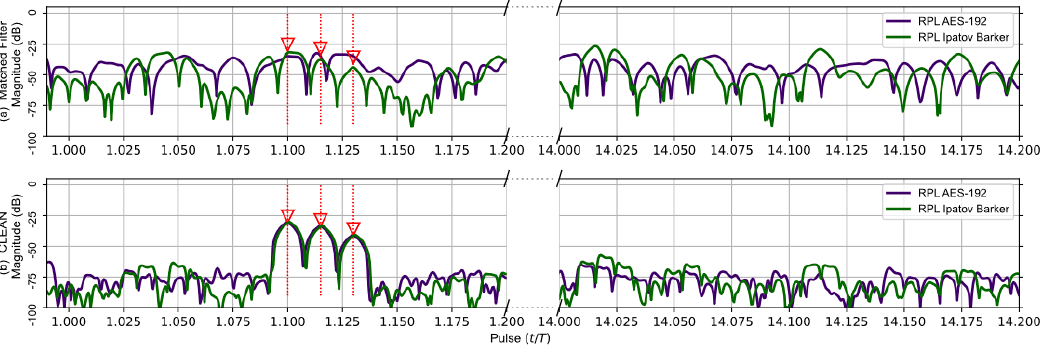
Figure 8. Duplicate data from Figure 7; focused on the tight group of three targets buried in the side lobes before CLEAN. The CLEAN algorithm was able to recover the buried